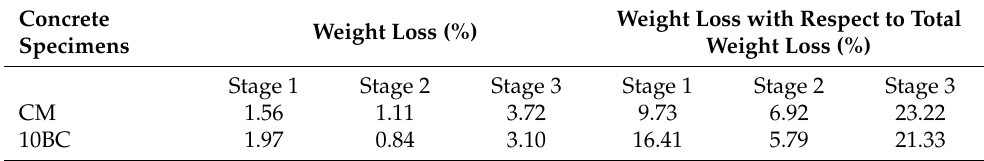
Figure 13. TGA results of control and bagasse mix. Table 6. Thermogravimetric weight loss of cement paste containing SCBA at 90 days of curing.